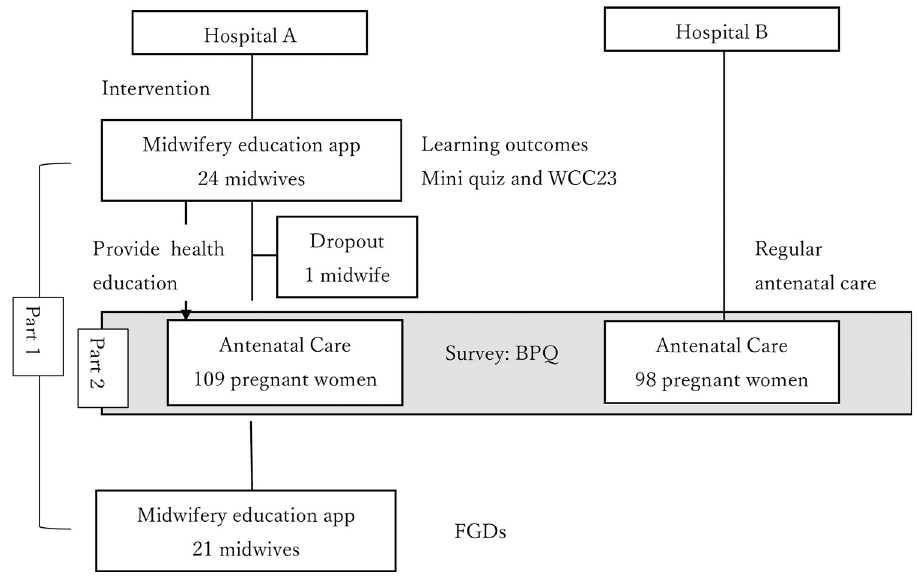
Fig 1. Recruitment and data collection